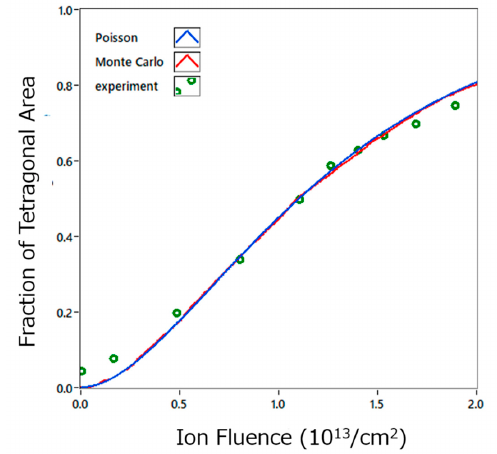
Figure 5. Fraction of tetragonal structure area of ZrO 2 as a function of ion fluence. Green circles, blue line, and red line represent the experimental result [16], result calculated by Equation (11)